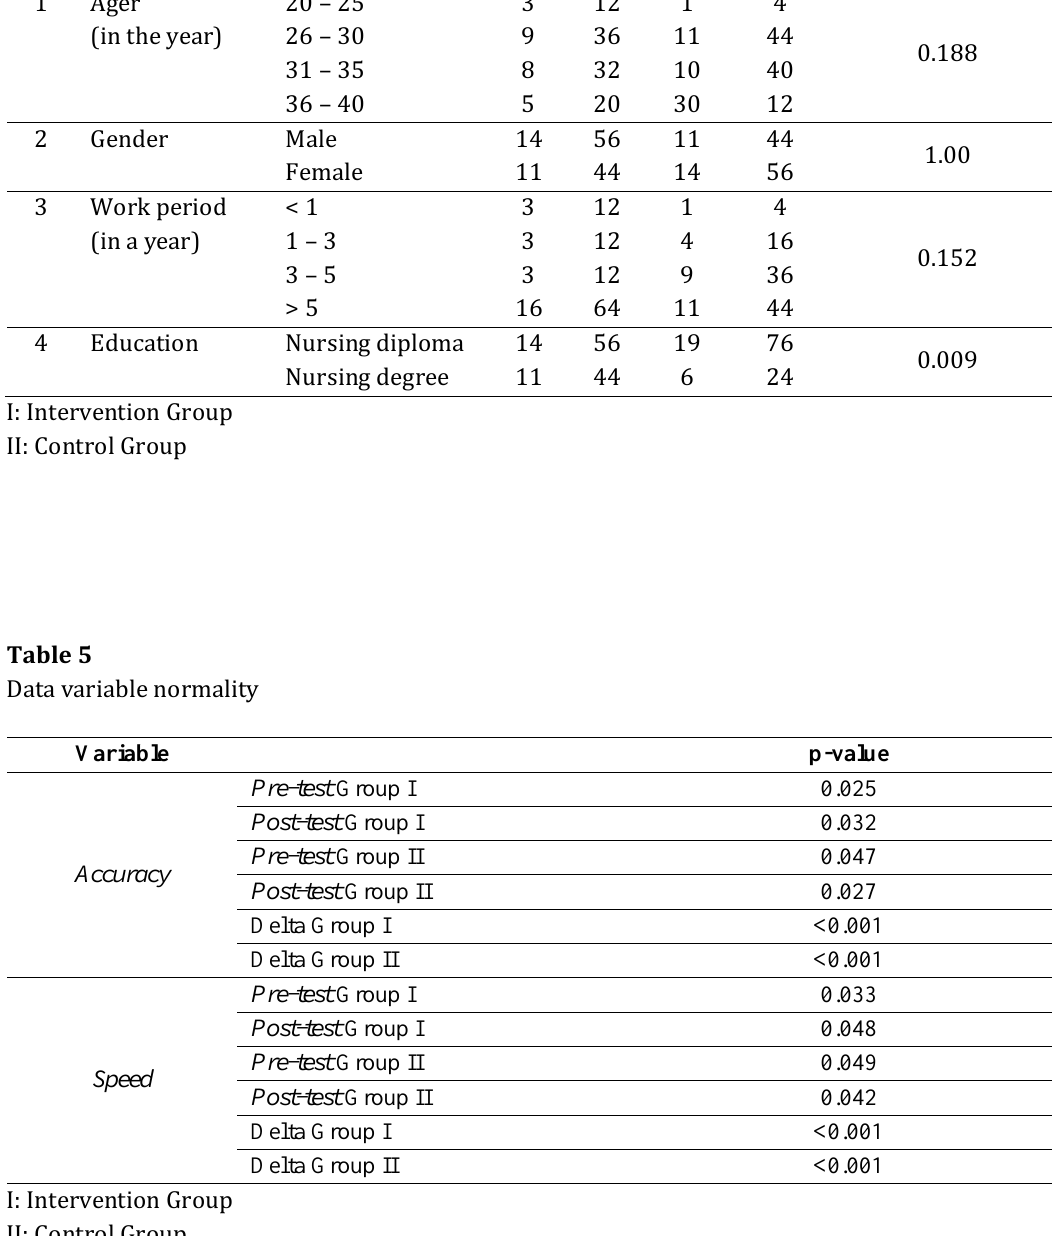
Distribution and homogeneity of the respondent characteristic of phase II No